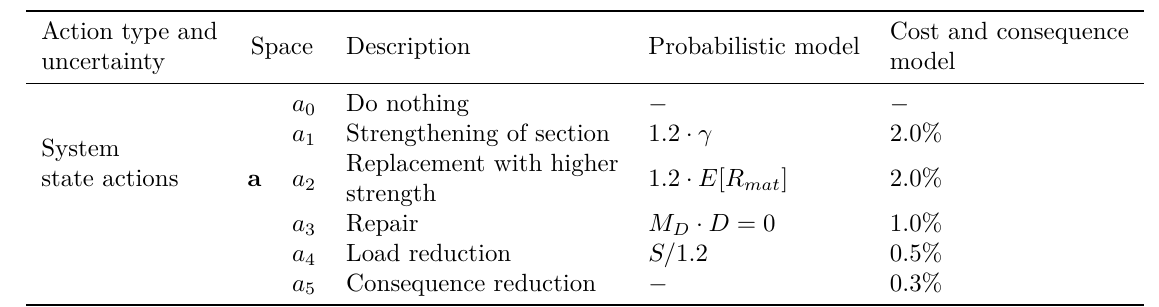
Table 2. Action type and cost models.